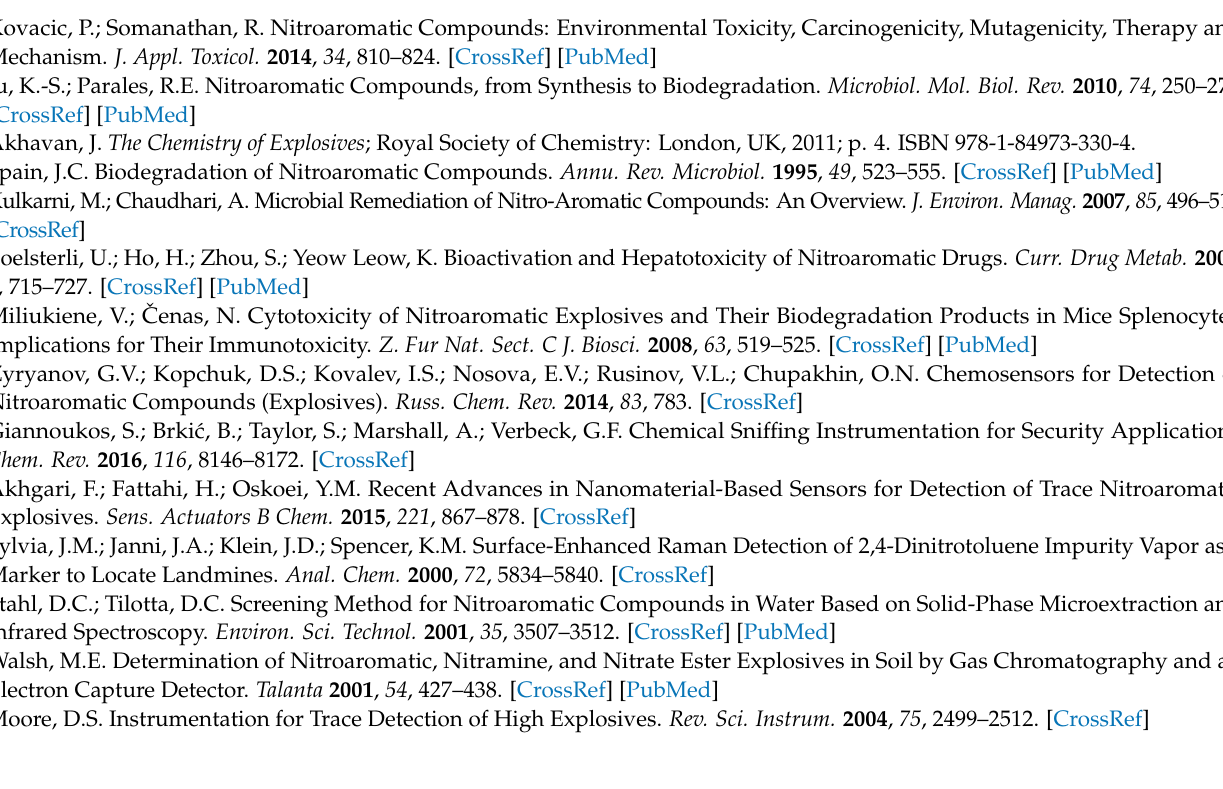
Figure S8: The comparison of BIP (8.0 × 10 − 7 M) and ZnPIP (7.6 × 10 − 7 M) solutions in toluene fluorescence spectra toluene ( λ ex = 346 nm) under the same experimental conditions. In the inset: the zoomed ZnPIP spectrum; Figure S9: The fluorescence (the green curve) and UV-vis absorbance (the black curve) spectra of ‘ ZnPIP in PMMA ’ solid film under 346 nm excitation; Figure S10: The UV-Vis and fluorescence ( λ ex = 346 nm) titration of ZnPIP solution (7.5 × 10 − 7 M) with C 6 F 6 in